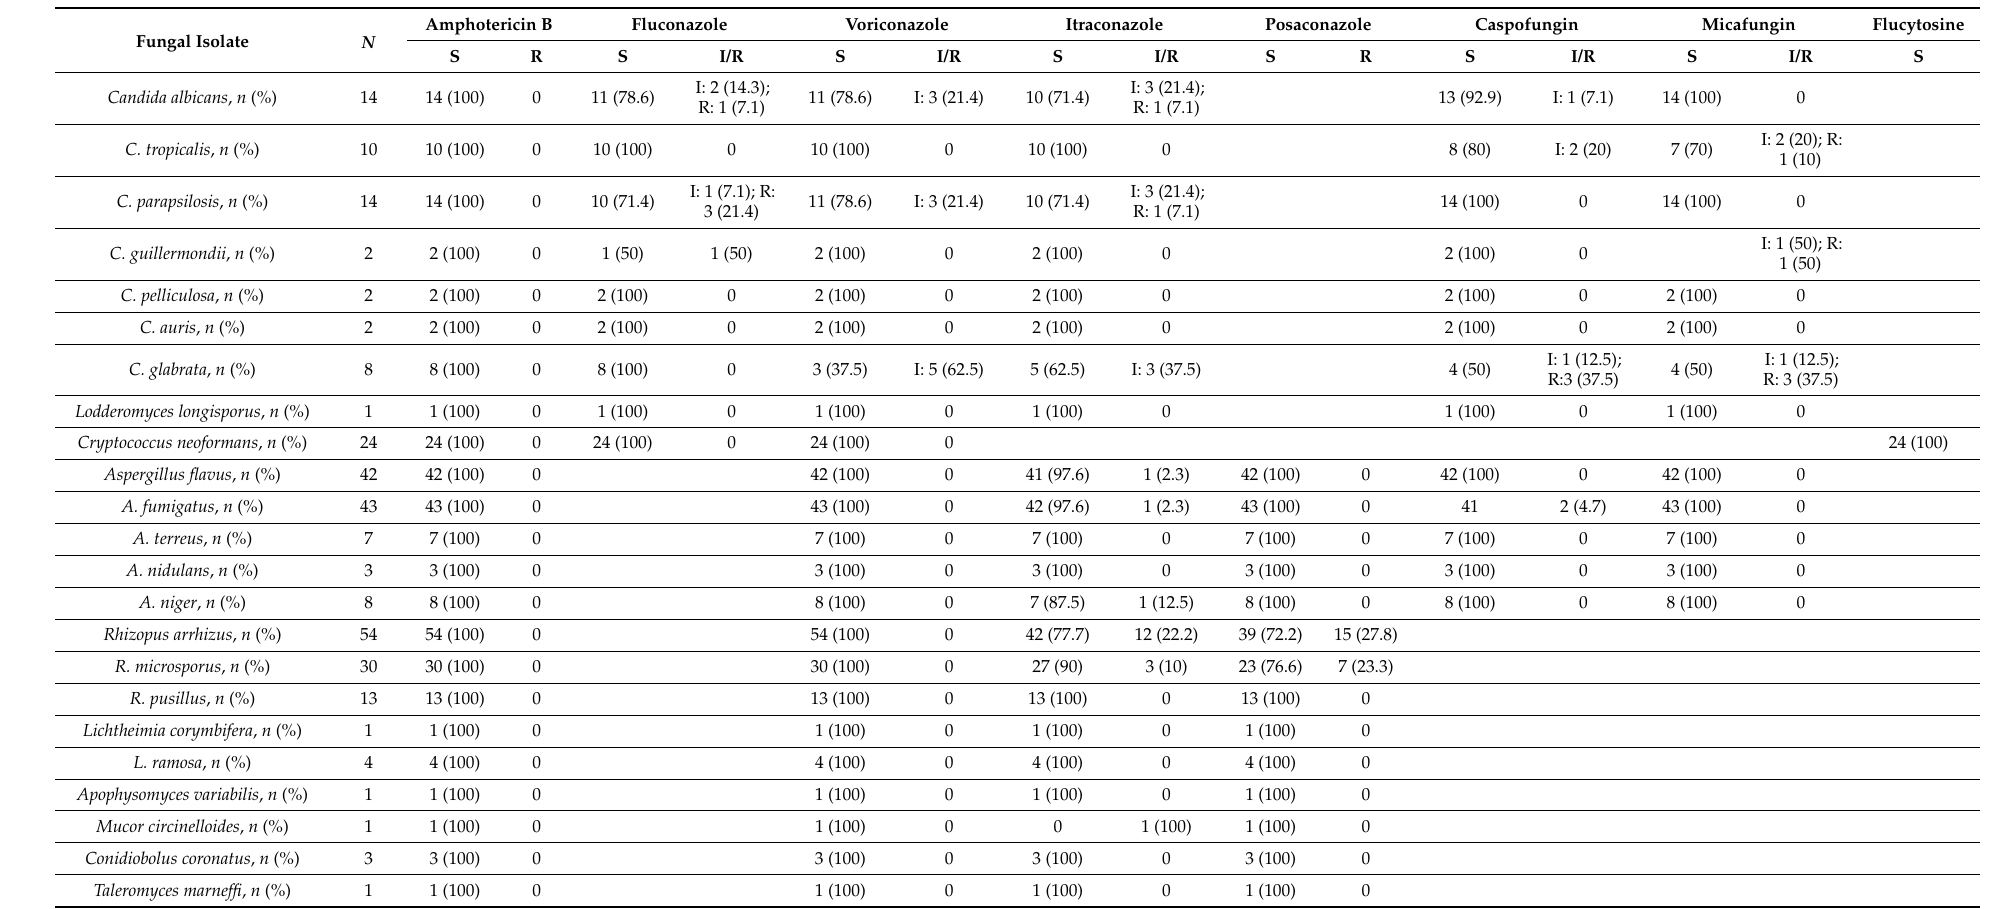
Table 5. MIC interpretation for various fungi from IFI